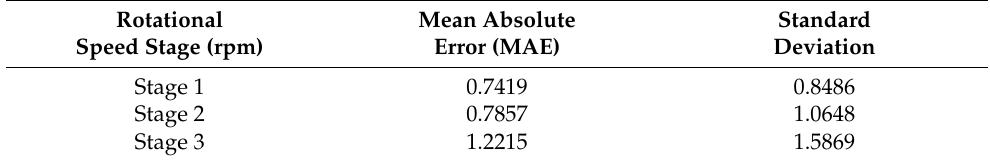
Table 3. Results for the MAE for the measurement method experimental evaluations with the fan.